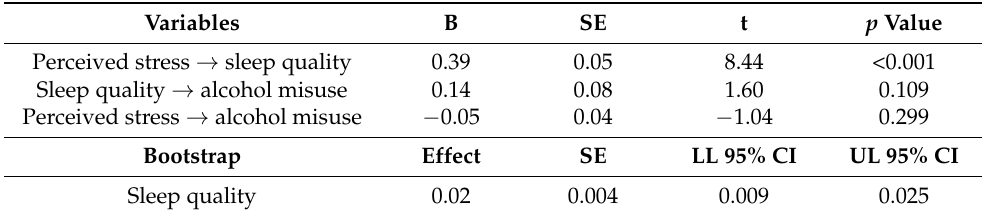
Table 10. Model 3 mediation